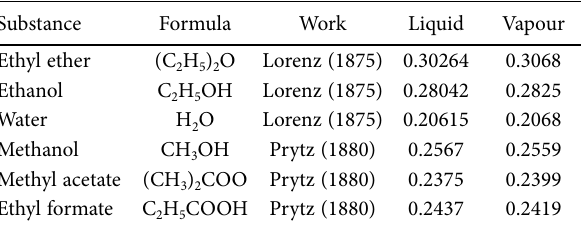
Table 1. Data for the quantity ( n 2 – 1)/( n 2 + 2) obtained by Lorenz and Prytz. Source: Rücker